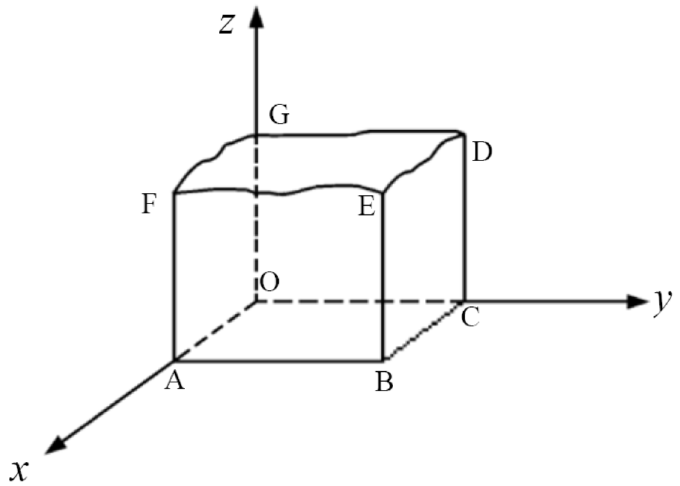
Figure 1. Sketch of 3-D calculating model.